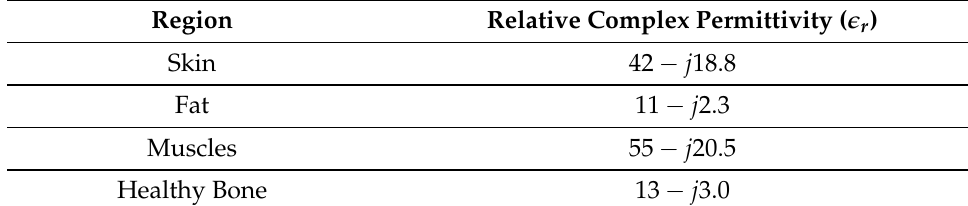
Table 1. Bulk electrical properties in the human leg model at 0.8 GHz.